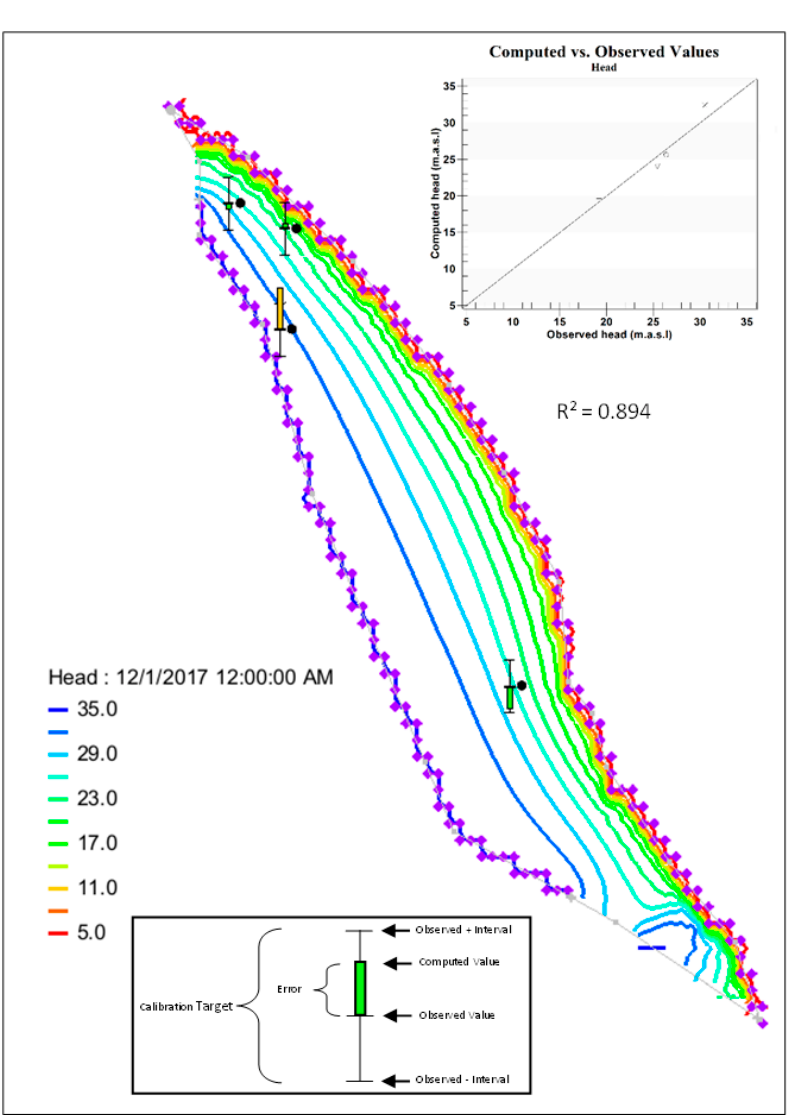
Figure 7. Contour map of the simulated aquifer groundwater level on 1 December 2017.